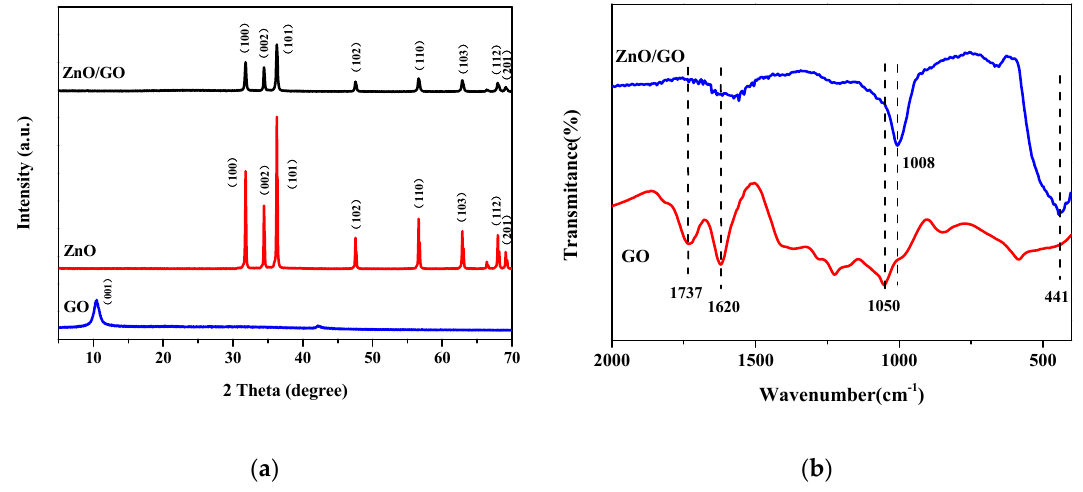
Figure 3. ( a ) XRD spectra of GO, pure ZnO and ZnO/GO, ( b ) Fourier transform infrared spectroscopy (FTIR) spectra of GO and ZnO/GO.